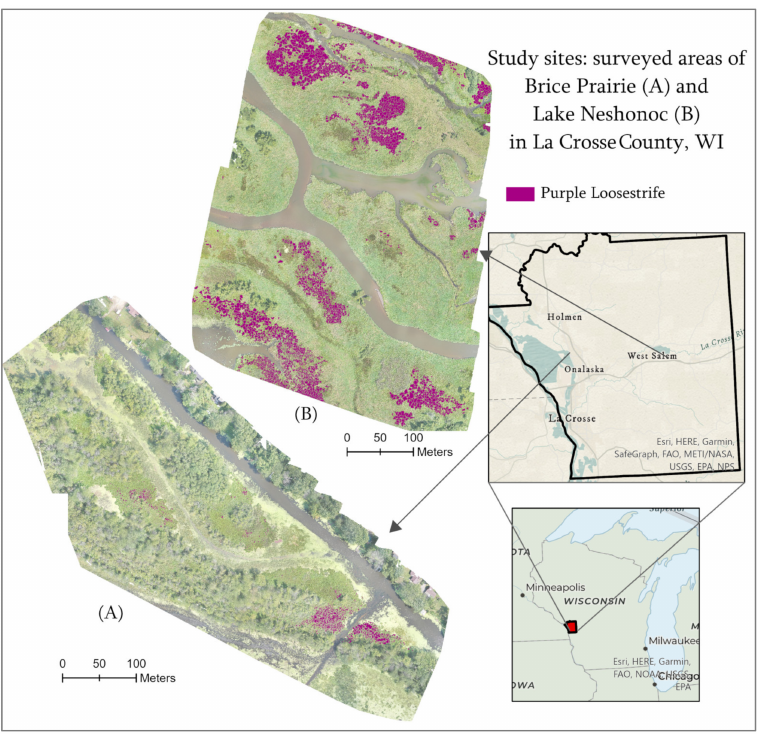
Figure 1. Study area map showing mosaicked images of Brice Prairie site ( A ) and Lake Neshonoc ( B ) site. The purple-colored polygons show the outline of the purple loosestrife